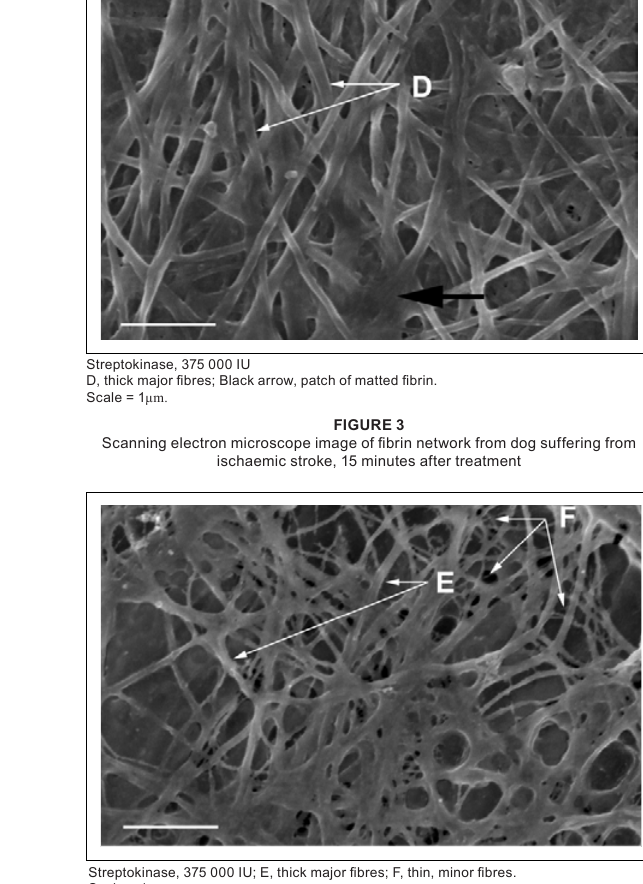
FIGURE 2 Scanning electron microscope image of fibrin network from dog suffering from ischaemic stroke (pre-treatment)